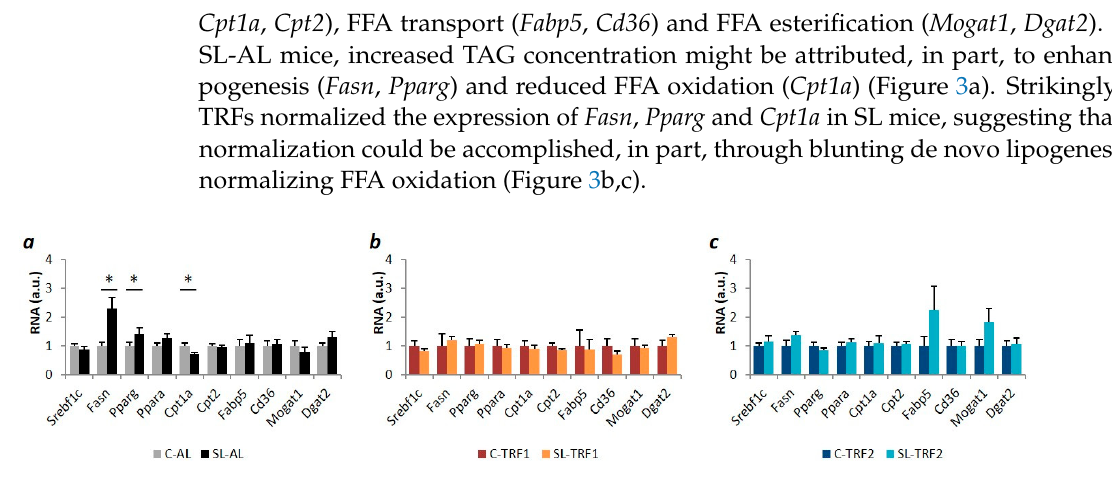
Figure 4. The chrono-nutritional interventions influence the expression of the hepatic clock genes in SL mice. ( a ) mRNA expression levels of the clock genes at different Zeitgeber Time (ZT) during a 24-h cycle in SL-AL mice (black) ( n ≥ 10), SL-